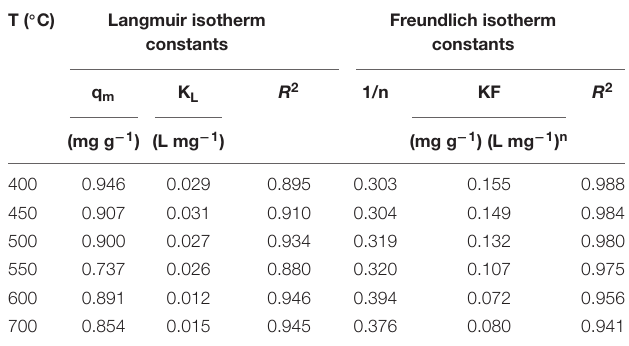
TABLE 4 | The Langmuir and Freundlich adsorption isotherm constant of BCCP under different calcined temperatures. T ( ◦